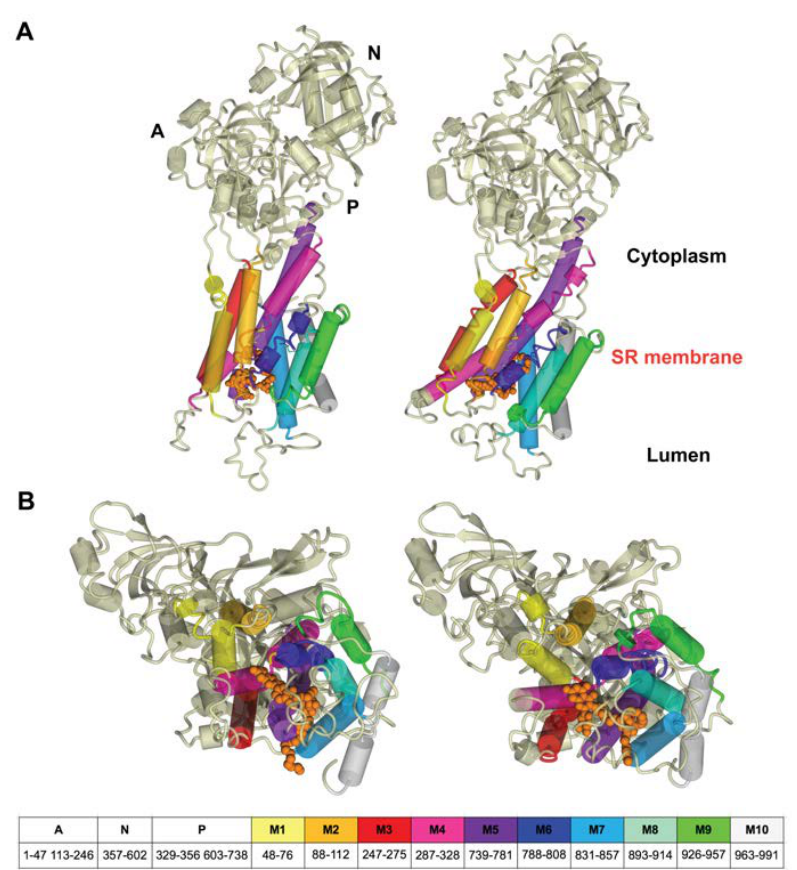
Figure 7. Rearrangement of transmembrane regions M1-M10 during the MD simulation: ( A ) side view; ( B ) view from the lumen. Structures at the beginning (left panel) and after 200 ns MD simulation (right panel). The cytoplasm domains (A, N, and P) and the transmembrane helices (M1 to M10) legend and residue numbering are shown at the bottom. The residues not assigned to domains are loops between individual transmembrane helices occurring in the lumen. Rutin arachidonate is depicted as a space-filling model in orange. Figures were rendered using YASARA [42].